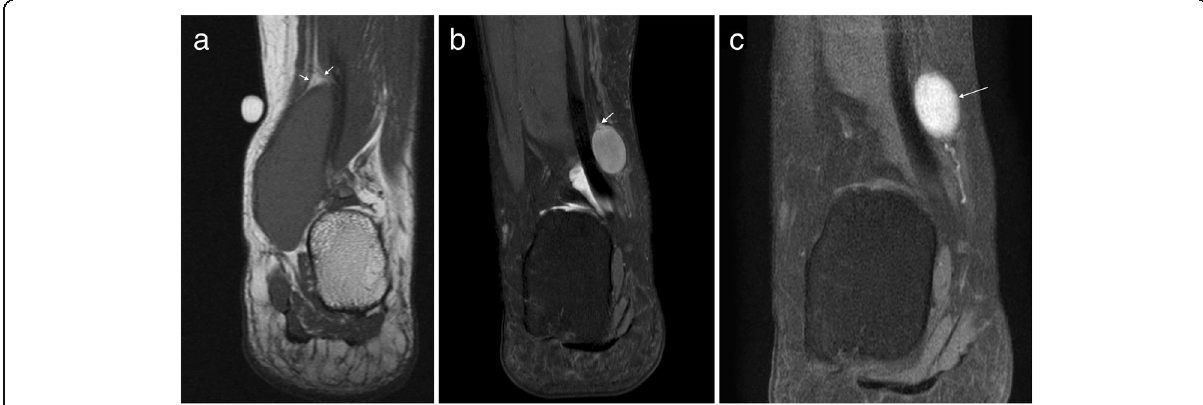
Fig. 10 Schwannoma. a Coronal T1W image demonstrating a well-defined homogeneously T1 isointense lesion with the split fat sign (arrows). b Coronal T2FS image of another schwannoma showing a homogeneously hyperintense lesion with a “ ball on a string ” sign denoting origin from the posterior tibial nerve (arrow). c The same lesion demonstrates avid enhancement on the post-contrast T1FS